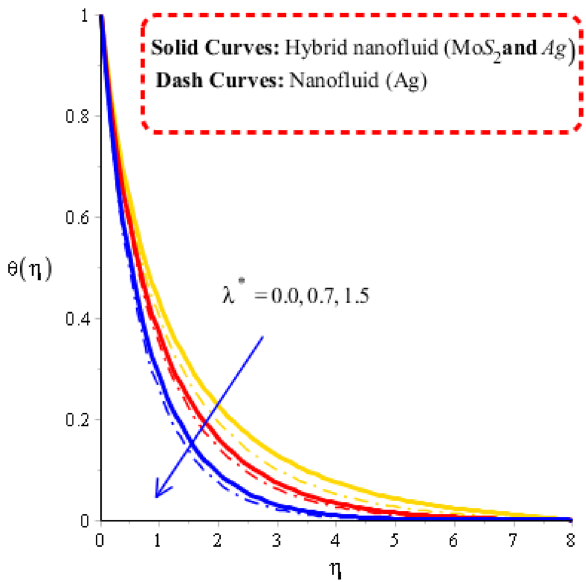
0.2, γ 0.7, Fr 0.26, Pr 204, Hs 1.7, (cid:31) 1.3, = = = = = − =